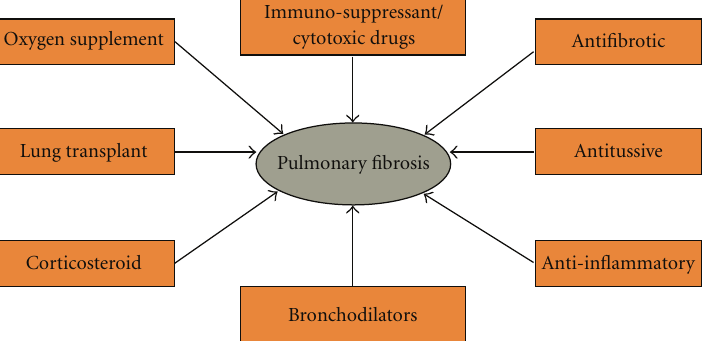
Figure 1: Present treatment options for PF. Available treatment options for PF include antitussives and bronchodilators, which relieve symptoms of dry unproductive cough and bronchospasm, respectively. In addition, corticosteroids are often administered for sustained relief of bronchospasm. Immunosuppressive/cytotoxic agents are usually reserved for patients not responding to steroid treatment or su ff ering from adverse side e ff ects. Lung transfer surgery is only considered in patients less than 65 years of age and can lead to fatal complications. Oxygen supplementation has positive outcomes on patient health. However, the personal inconvenience may a ff ect patient